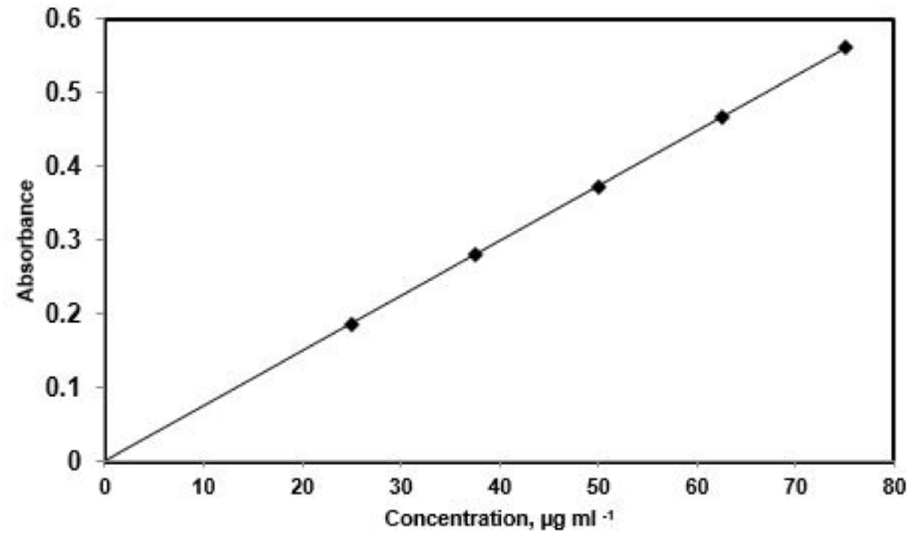
FIGURE 4 - Calibrated curve of PPE-DCQC